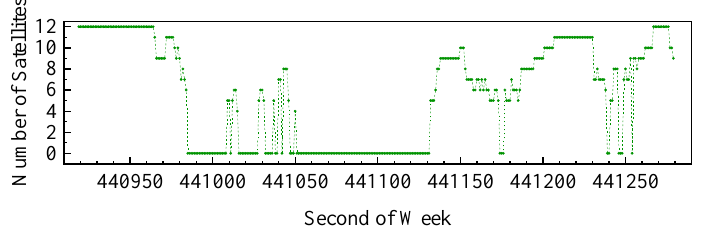
Figure 8. Number of satellites in the urban area.